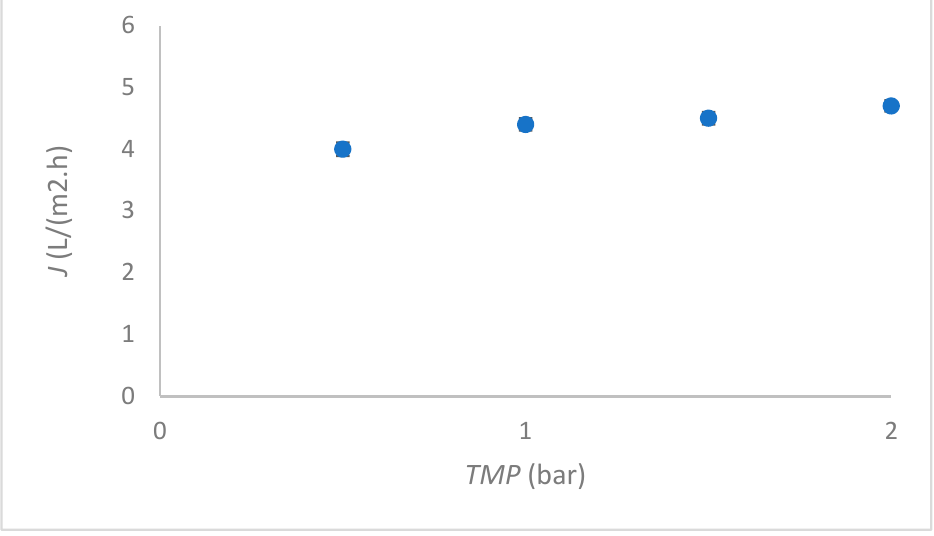
Figure 3. Flux dependent on TMP for the ceramic membrane at filtering whey. Flux measurements for whey and those of Millipore water before and after